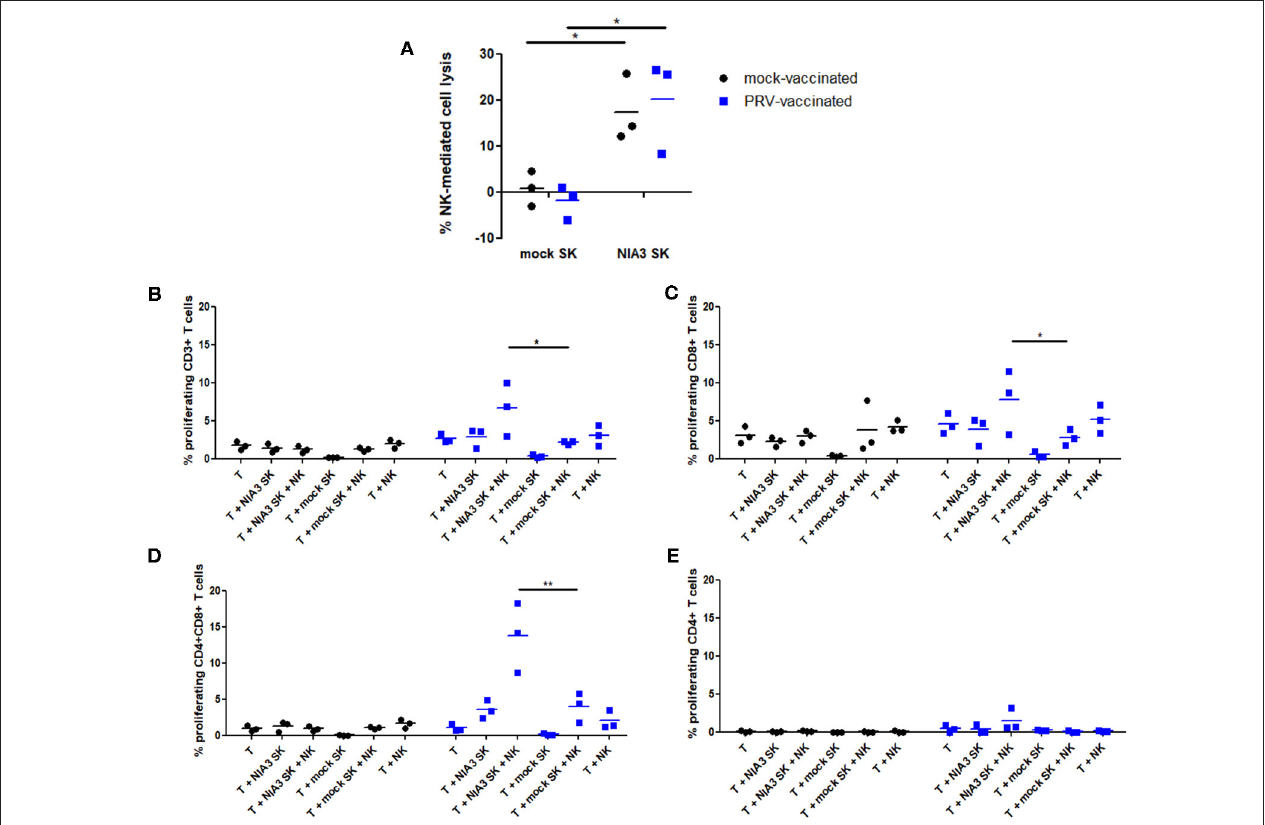
FIGURE 4 | NK cells from PRV-vaccinated pigs stimulate T cell proliferation of PRV-experienced CD8 + and CD4 + CD8 + T cells after killing of PRV-infected target cells. (A) SK cells were mock-infected or PRV-infected and subsequently incubated with NK cells from mock- or PRV-vaccinated animals for 4h at a effector:target ratio of 20:1. Viability of target cells was assessed by propidium iodide and flow cytometry. Dot plots show the results of the three animals in each group (mock- and PRV-vaccinated) and the mean values are indicated with a horizontal line. (B–D) PRV-stimulated NK cells were either or not co-cultured with medium, mock- or PRV-infected target SK cells at an effector:target ratio of 20:1. After 2h co-incubation, violet dye-labeled CD6 + T cells were added and incubated for 4 days. Dot plots show the T cell proliferation of CD3 + (B) , CD8 + (C) CD4 + CD8 + (D), and CD4 + (E) T cells of the three animals in each group (left panels: mock-vaccinated animals, right panels: PRV-vaccinated animals). The mean values are indicated with a horizontal line. Statistically significant differences in T cell proliferation between NK cells that were pre-incubated with PRV-infected SK target cells vs. mock-infected SK target cells are indicated with asterisks (* p < 0.05; ** p <